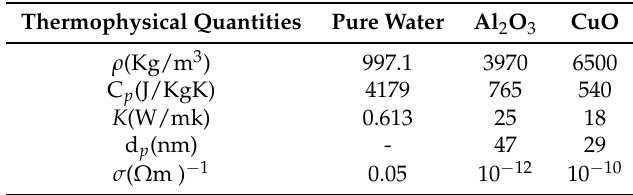
Table 1. Thermophysical quantities of water and nanoparticles [47].